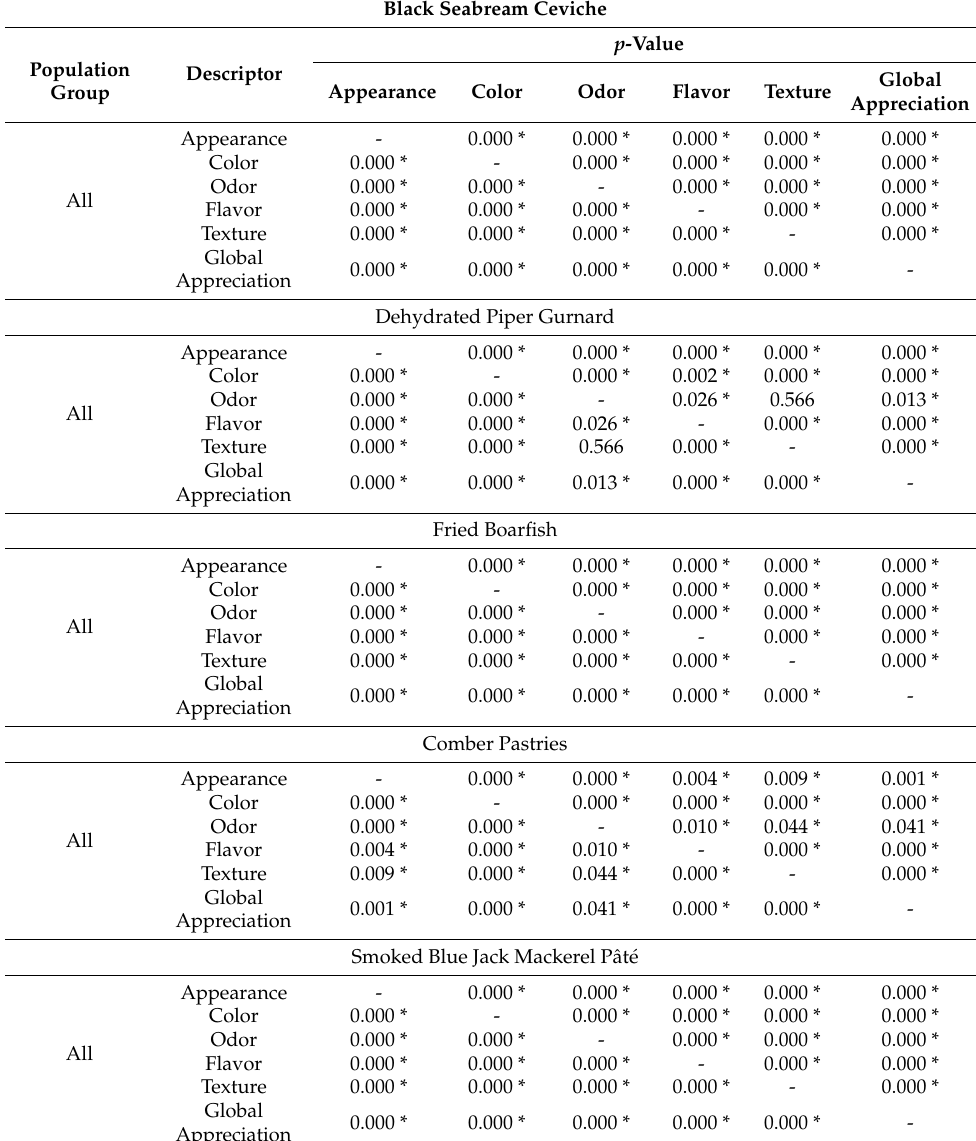
Table 5. Correlation with Spearman’s non-parametric test between all descriptors (appearance, color, odor, flavor, texture, and global appreciation) for each fish product developed ( n =